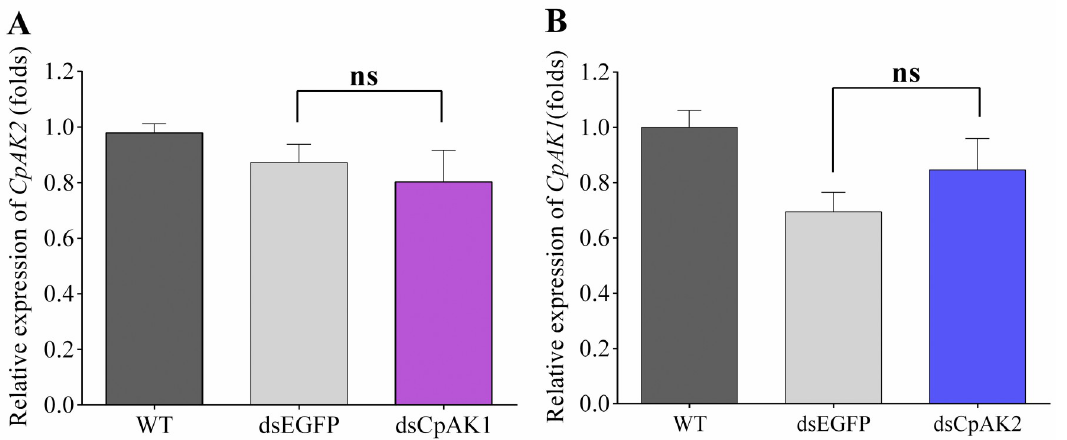
Fig 4. Relative expression levels of CpAK2 (A) and CpAK1 (B) after injection of dsRNAs in Cx . pipiens pallens . All data were expressed as the mean ± Standard Error (SE).“ns”means “no significant difference”.